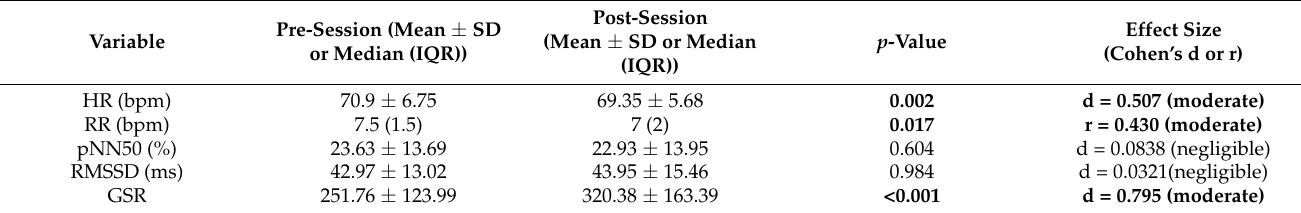
Table 4. Physiological stress indicators before and after relaxation session.